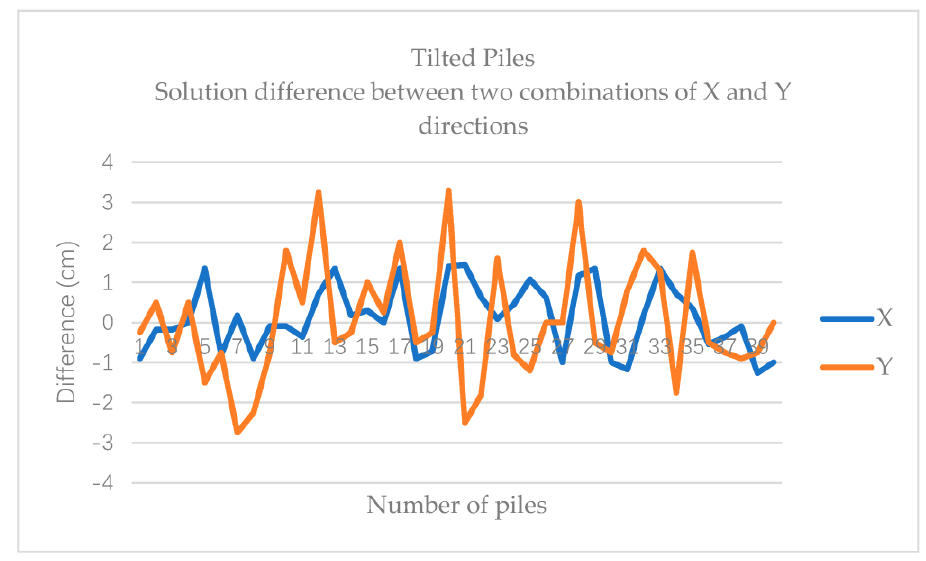
Figure 16. Solution di ff erence between two combinations in X and Y directions for tilted piles.